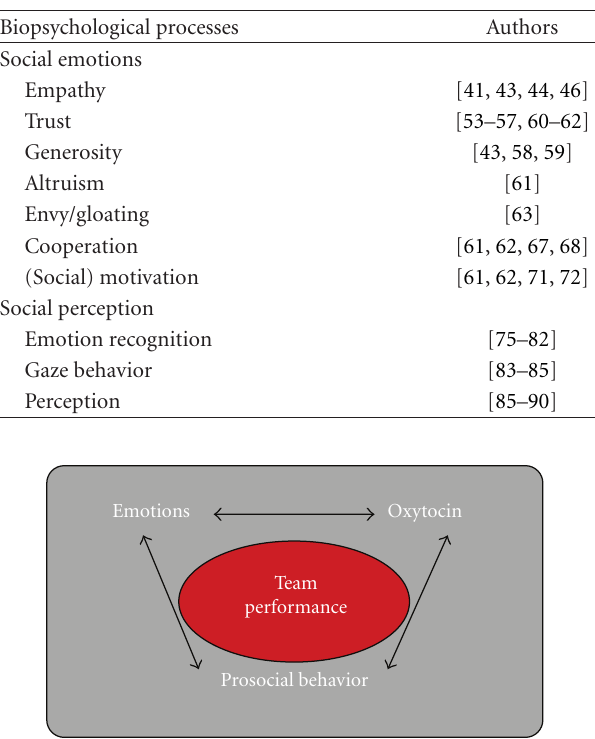
Table 1: Overview of studies reviewed ( n = 36) that show supportive evidence for oxytocin as a neuropeptide involved in the encouragement of biopsychological processes linked to greater team performance in sport.